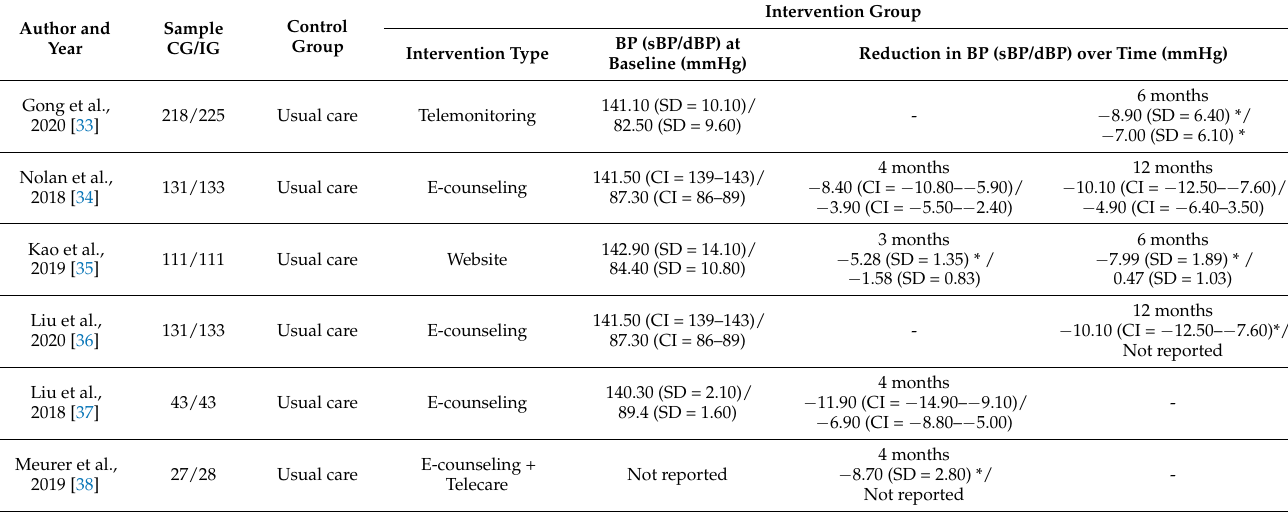
Table 3. Effects of telemedicine-based interventions in persons